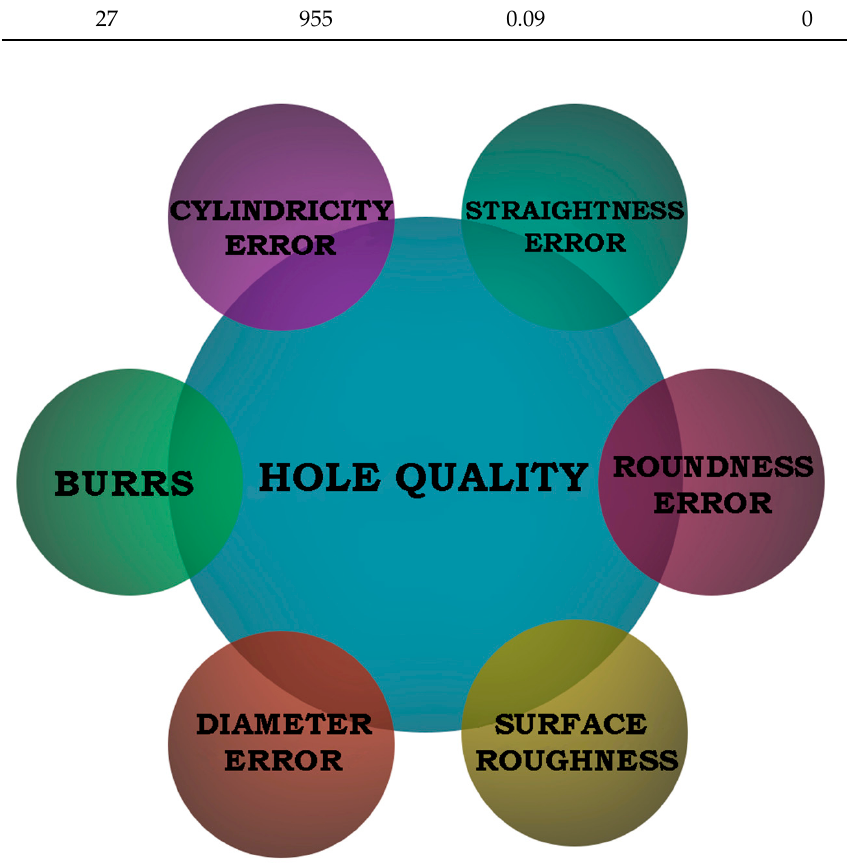
Figure 3. Parameters describing the hole quality.